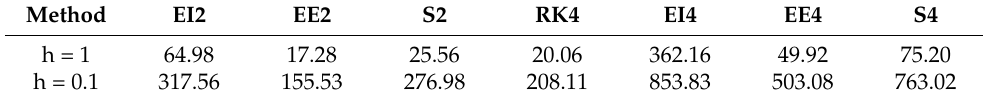
Table 2. Same as Table 1. Computational cost, i.e., CPU times (seconds), for algorithms.